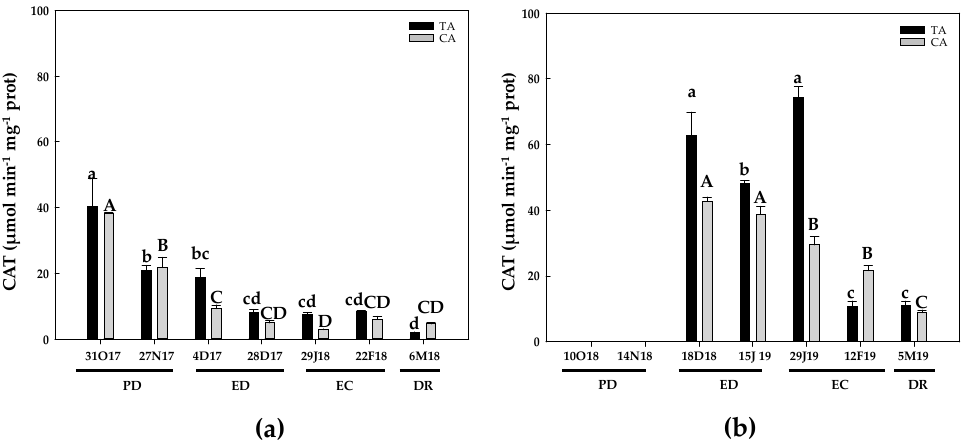
Figure 15. Evolution of catalase (CAT) activity in flower buds of peach ‘GEM020’ cultivated in two different geographical areas during the dormancy cycle on two seasons. ( a ): season 1 (2017–2018); ( b ): season 2 (2018–2019). Data represent the mean ± SE, n = 5. Different letters (lowercase and uppercase for the samples of the temperate (TA) and the cold area (CA), respectively) indicate significant differences according to Tukey’s multiple test ( p ≤ 0.05). PD: paradormancy; ED: endodormancy; EC: ecodormancy; DR: dormancy release. FW: fresh weight. The chill units accumulated at the different times and locations are shown in Supplemental file 1.